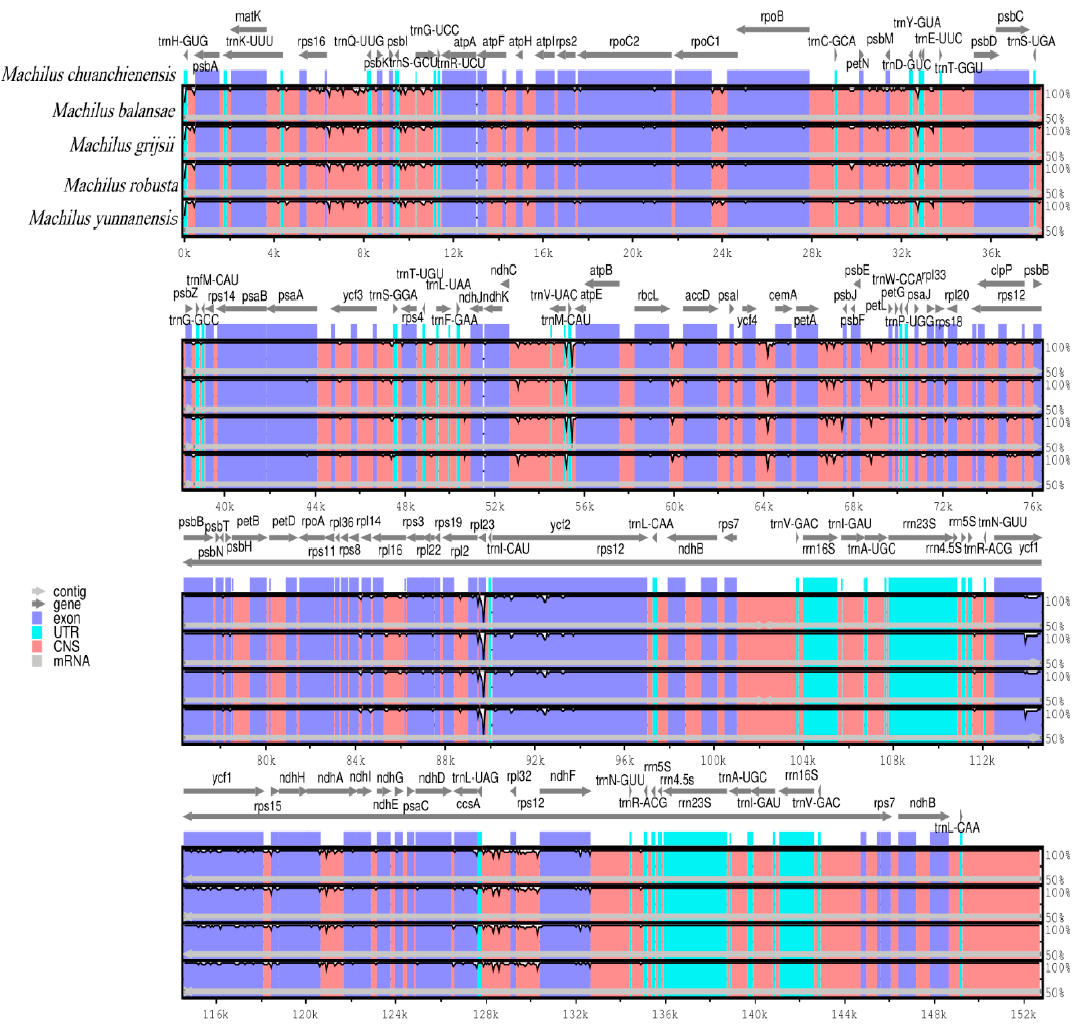
Figure 4. Variations in the chloroplast genome sequences of M. chuanchienensis and four related species. The gray arrows indicate the location and orientation of the genes, and the white part indicates the variations between the sequences. CNS represents conservative non-coding sequence.